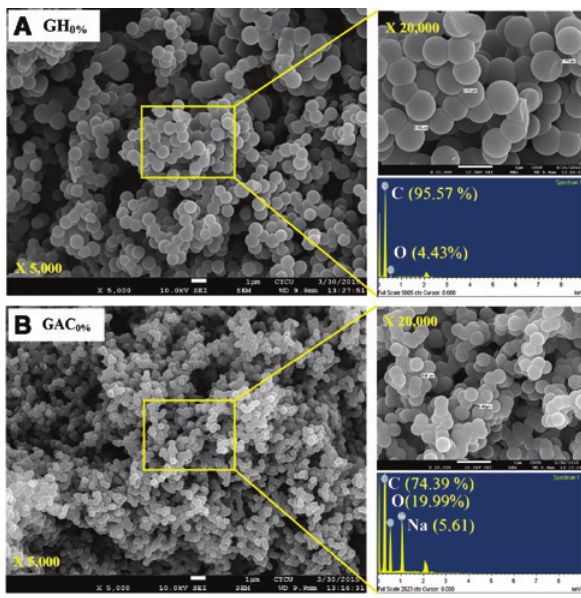
Figure 2: Scanning electron microcopy-energy dispersive X-ray (SEM-EDX) spectra of the (A) glucose-derived hydrochar (GH) (B) glucose-activated carbon (GAC)